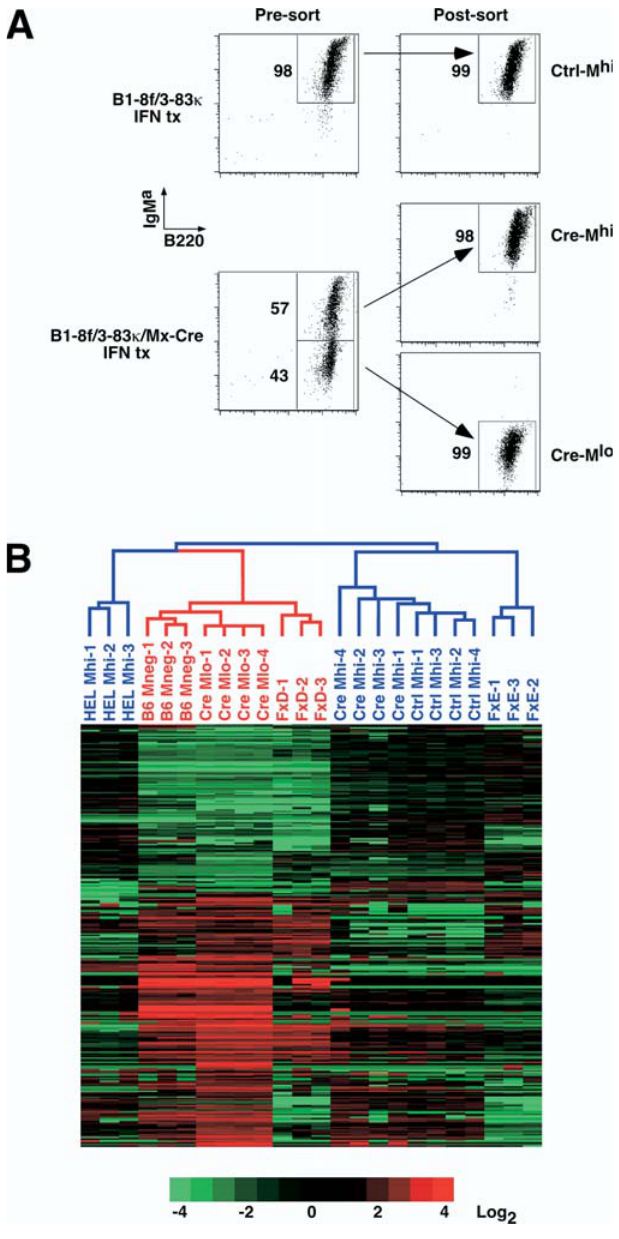
Figure 2. Microarray Gene Expression Analysis Demonstrates Co- Clustering of Cre-Deleted IgM lo Cells with IgM (cid:1) Cell Populations (A) FACS sorting strategy for Ctrl-M hi , Cre-M hi , and Cre-M lo immature B cells incubated with IFN ab (1,000 units/ml) for 2 d.